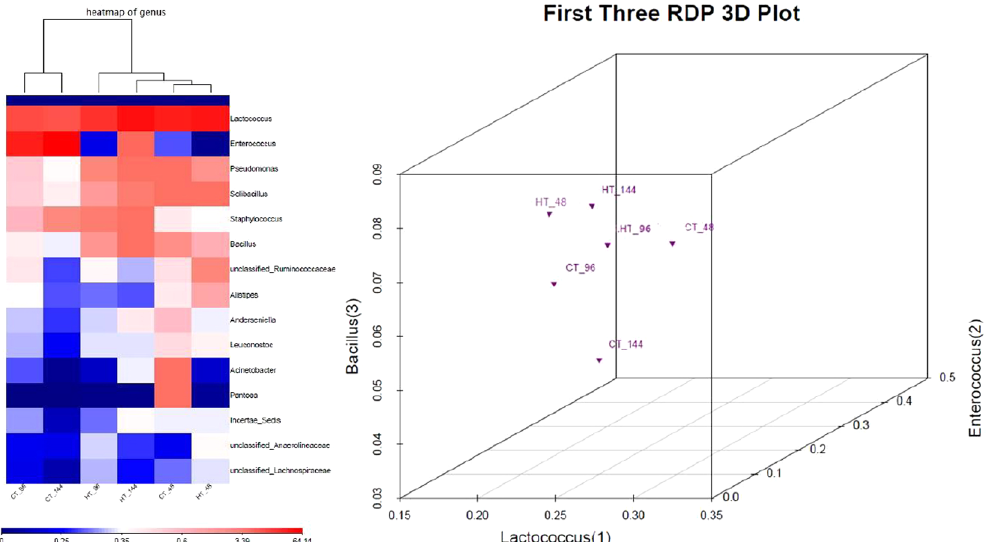
Figure 5. Heatmap and RDP 3D plot of the different samples. ( a ) A heatmap of bacterial communities in the CT-48, CT-96, CT-144, HT-48, HT-96 and HT-144 samples based on the top 15 dominant genera. Rows and columns represent the samples and dominant genera, respectively. The color blocks in the heat map represent weighted-UniFrac distances, and the lower number represents greater similarity in bacterial microbiota between samples in the heatmap. The deeper red color indicates a closer distance between samples, and the deeper blue color indicates a larger distance between samples. ( b ) A RDP 3D plot of bacterial communities in the CT- 48, CT-96, CT-144, HT-48, HT-96 and HT-144 samples based on the top 3 dominant genera ( Enterococcus , Lactococcus , Pseudomonas ). Closer spatial distances indicate more similarity between the